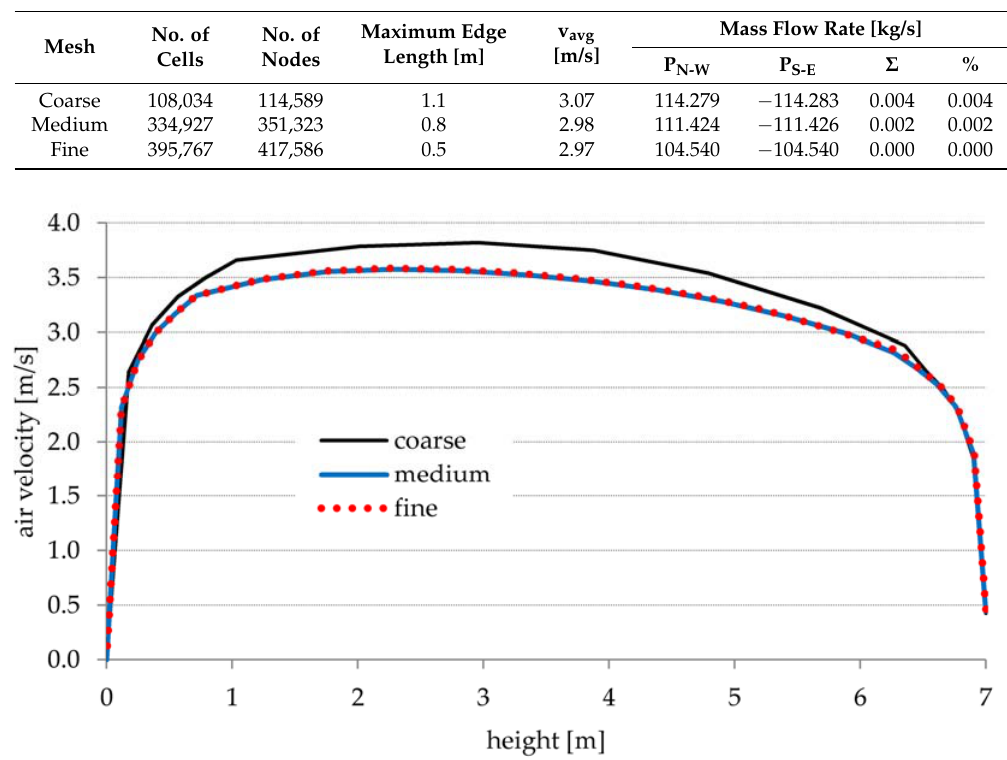
Figure 3. Vertical profiles of air velocity in the middle of the tunnel for three mesh densities.